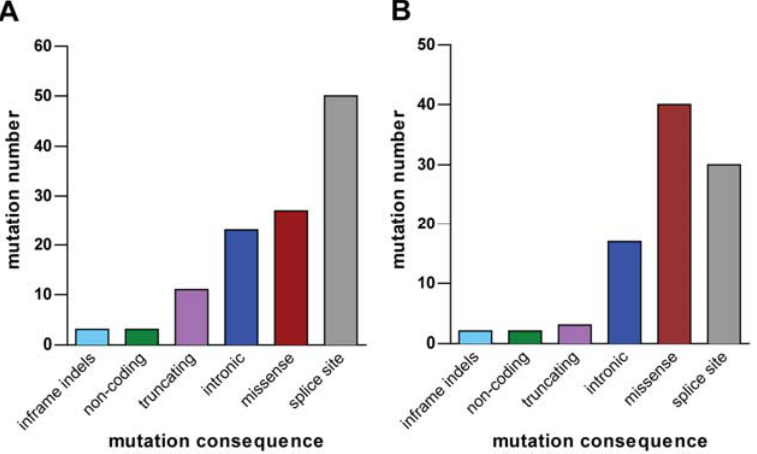
Figure 5. Histograms showing mutations present in the osteosarcoma ( A ) and in the leiomyosarcoma ( B ) cases, classified according to their effect on the protein. In the osteosarcoma case, the ATRX gene was identified as carrying a frameshift mutation (c.1283_1284insT) affecting exon 9 on chr23:77683973 (Table 2). This ATRX variant was also validated by Sanger sequencing and determined the loss of the reading frame, introducing a premature stop codon at position 428 (Figure 6). Table 2. Mutational analysis of gene variants in cardiac osteosarcoma (CS9) and leiomyosarcoma (CS11) cases.